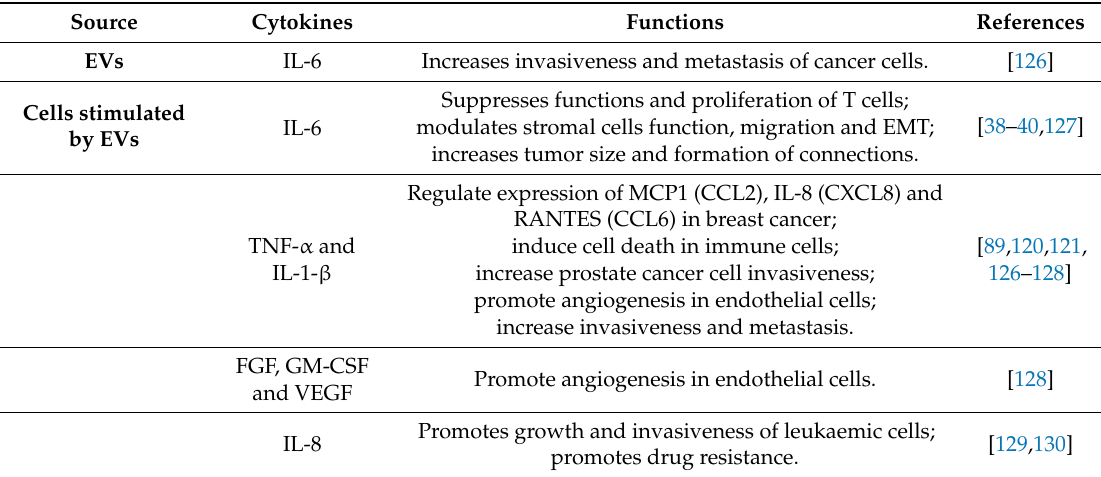
Table 3. Role of principal cytokines carried by sEVs and their role in cell communication within a